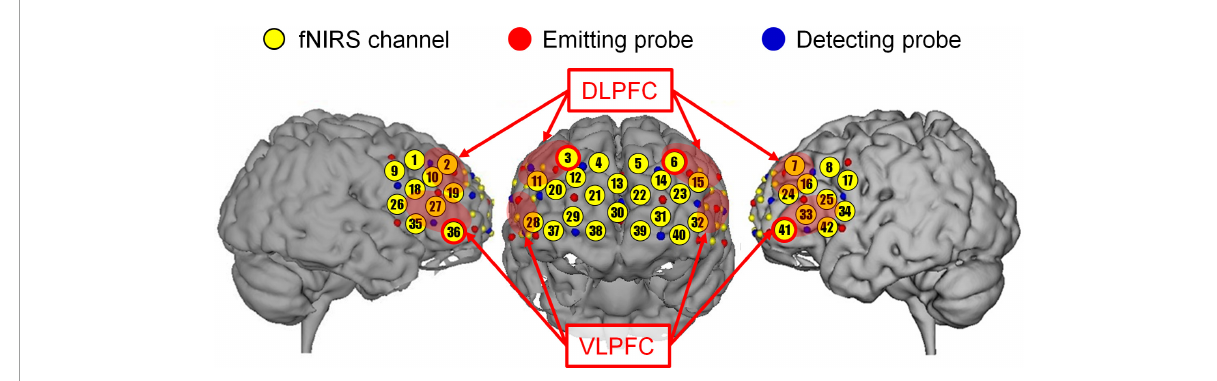
FIGURE2 Anatomical space of each functional near-infrared spectroscopy (fNIRS) channel. Regions of interest (ROIs) are circled in red. Upper left circle, right DLPFC (3 ch.); upper right circle, left DLPFC (6 ch.); lower left circle, right VLPFC (36 ch.); lower right circle, left VLPFC (41 ch.); Red shadings are the estimated anatomical regions (right DLPFC, 2, 3, 10, 11, and 19 ch.; left DLPFC, 6, 7, 15, 16, and 24 ch.; right VLPFC, 18, 27, 28, 35, and 36 ch.; left VLPFC, 25, 32, 33, 41, and 42 ch.; e.g., Yamaya et al.,